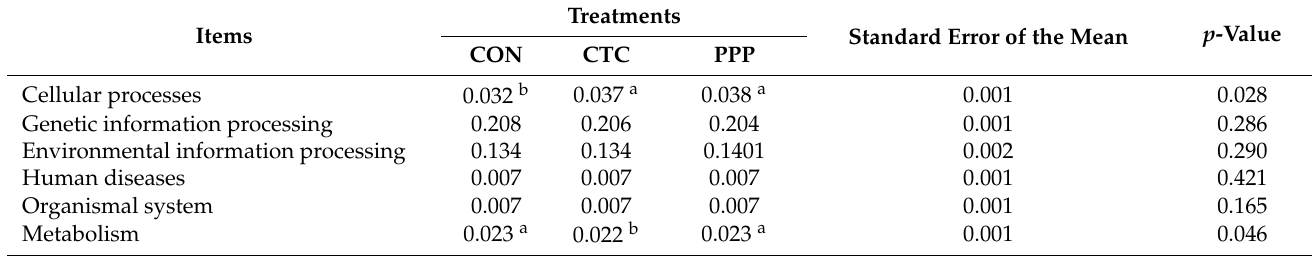
Table 8. Dietary pomelo peel powder affected the prediction function of intestinal flora.